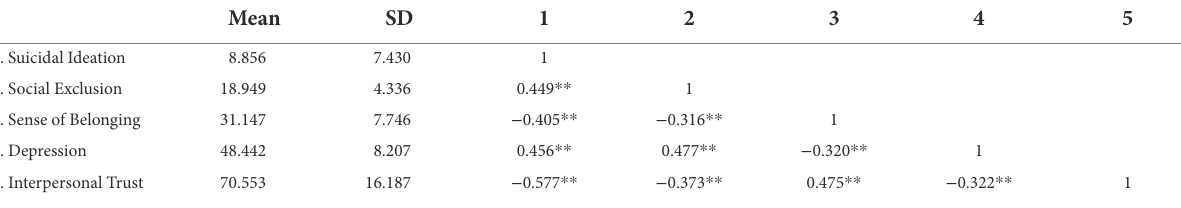
TABLE 1 Descriptive statistics and correlation